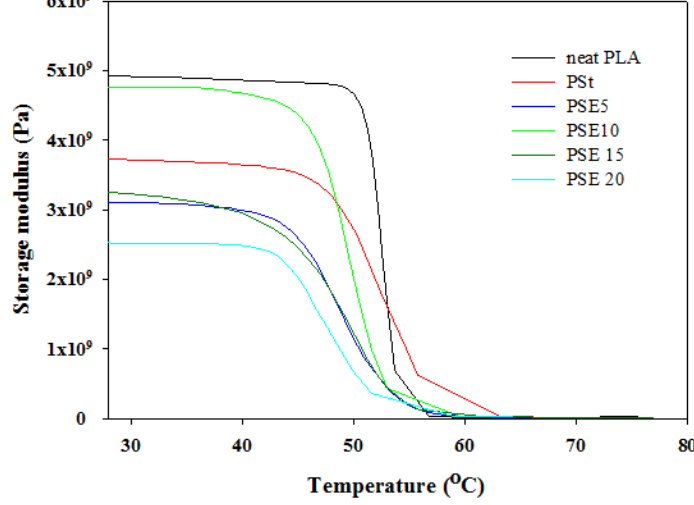
Figure 7. Storage modulus of neat PLA, PSt, and PSE blends.